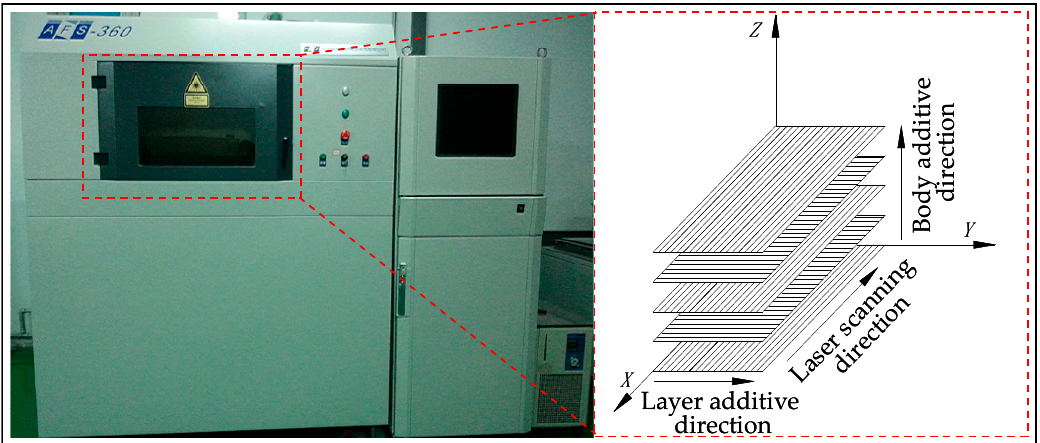
Figure 2. The equipment and building method.